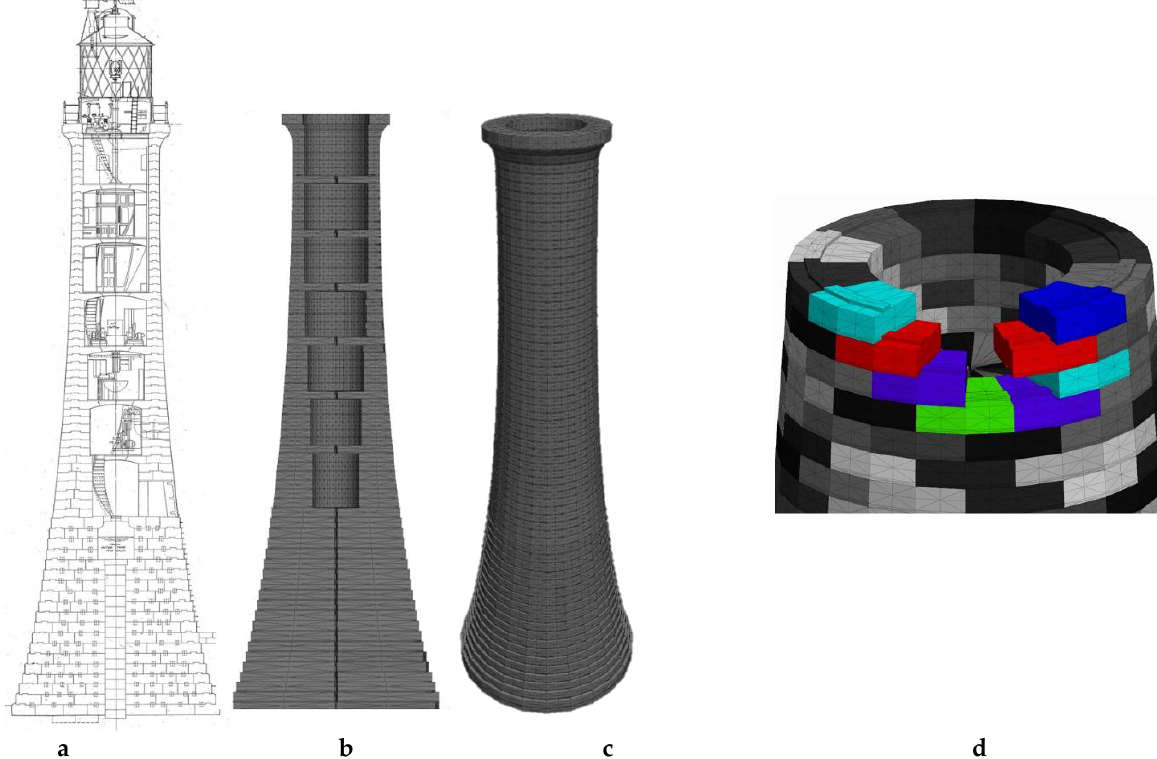
Figure 6. Wolf Rock lighthouse: ( a ) Wolf Rock lighthouse cross-section, 1964 (Trinity house archive [56]); ( b ) 3DEC model section; ( c ) model perspective view; and ( d ) detail of interlocking.